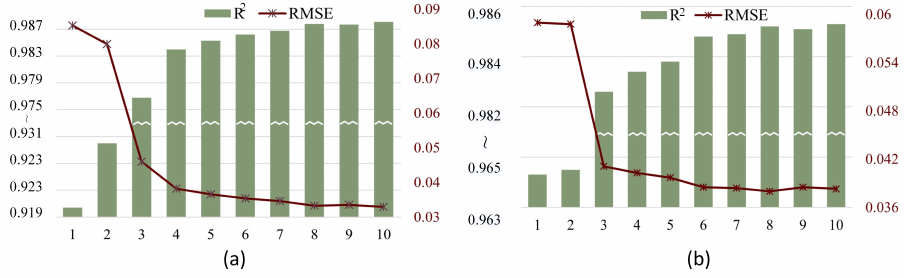
Figure 16. The experimental results using different numbers of logging features from ( a ) well Luo69 and ( b ) well